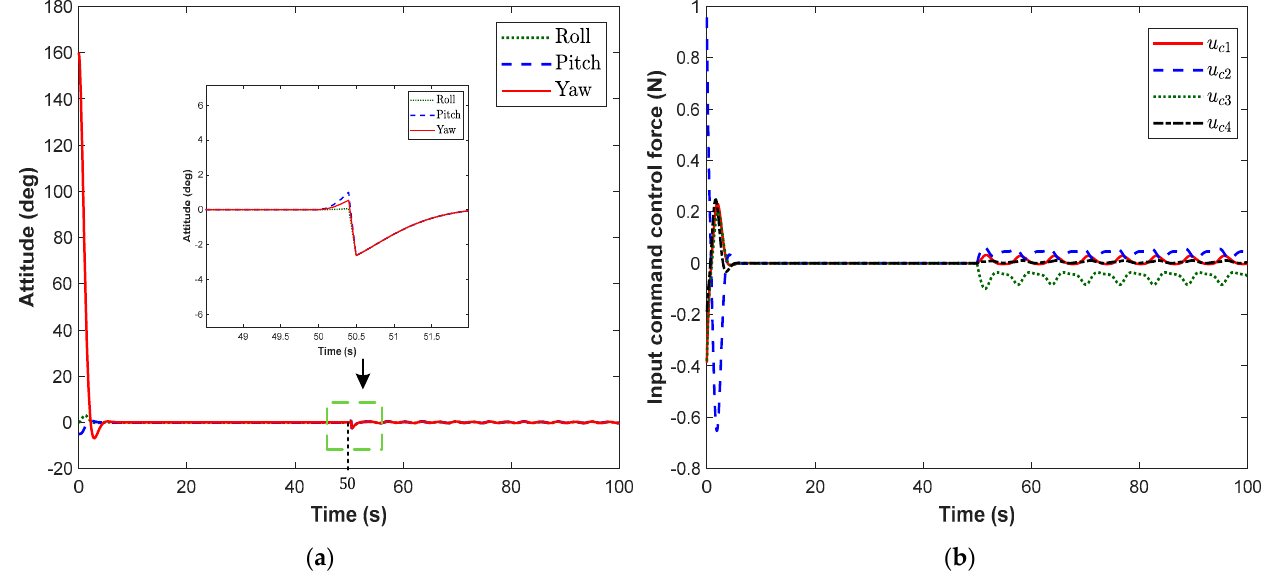
Figure 9. ( a ) Description of fault-tolerant control effect; and ( b ) description of system control input.